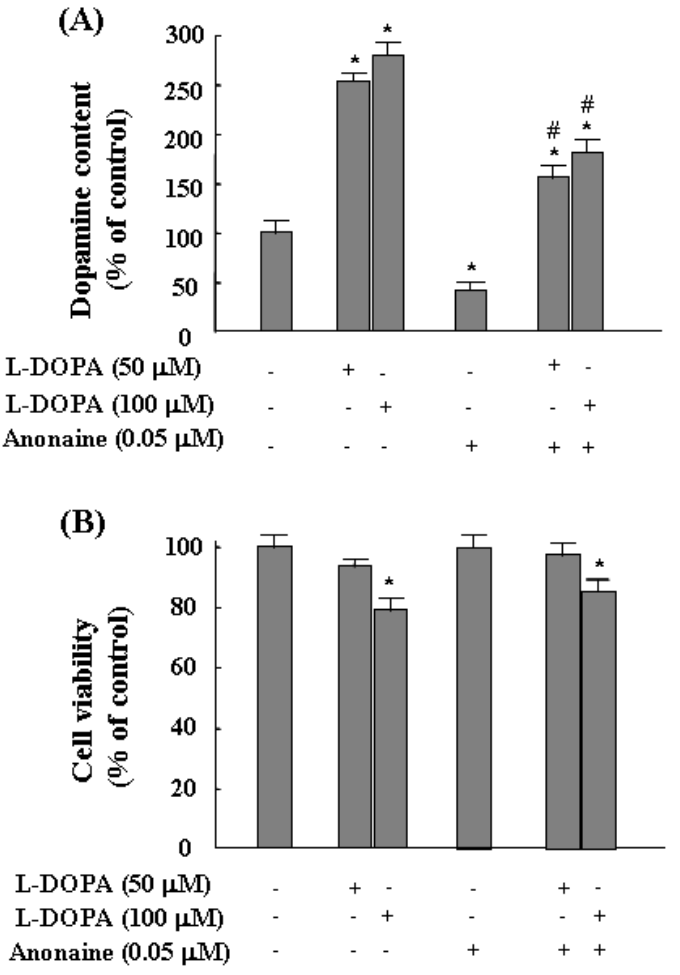
Figure 6 . Effects of anonaine on L -DOPA-induced dopamine content (A) and cytotoxicity (B) in PC12 cells. PC12 cells were exposed to L -DOPA (50 µM and 100 µM) in the absence or presence of anonaine (0.05 µM) for 24 h. Dopamine content and cell viability were determined by an HPLC system and MTT method as described under Materials and Methods. Results represent means ± S.E.M. of 6-8 dishes or wells. *P<0.05 compared to control values, #P<0.05 compared to the corresponding L -DOPA concentrations (ANOVA followed by Tukey’s